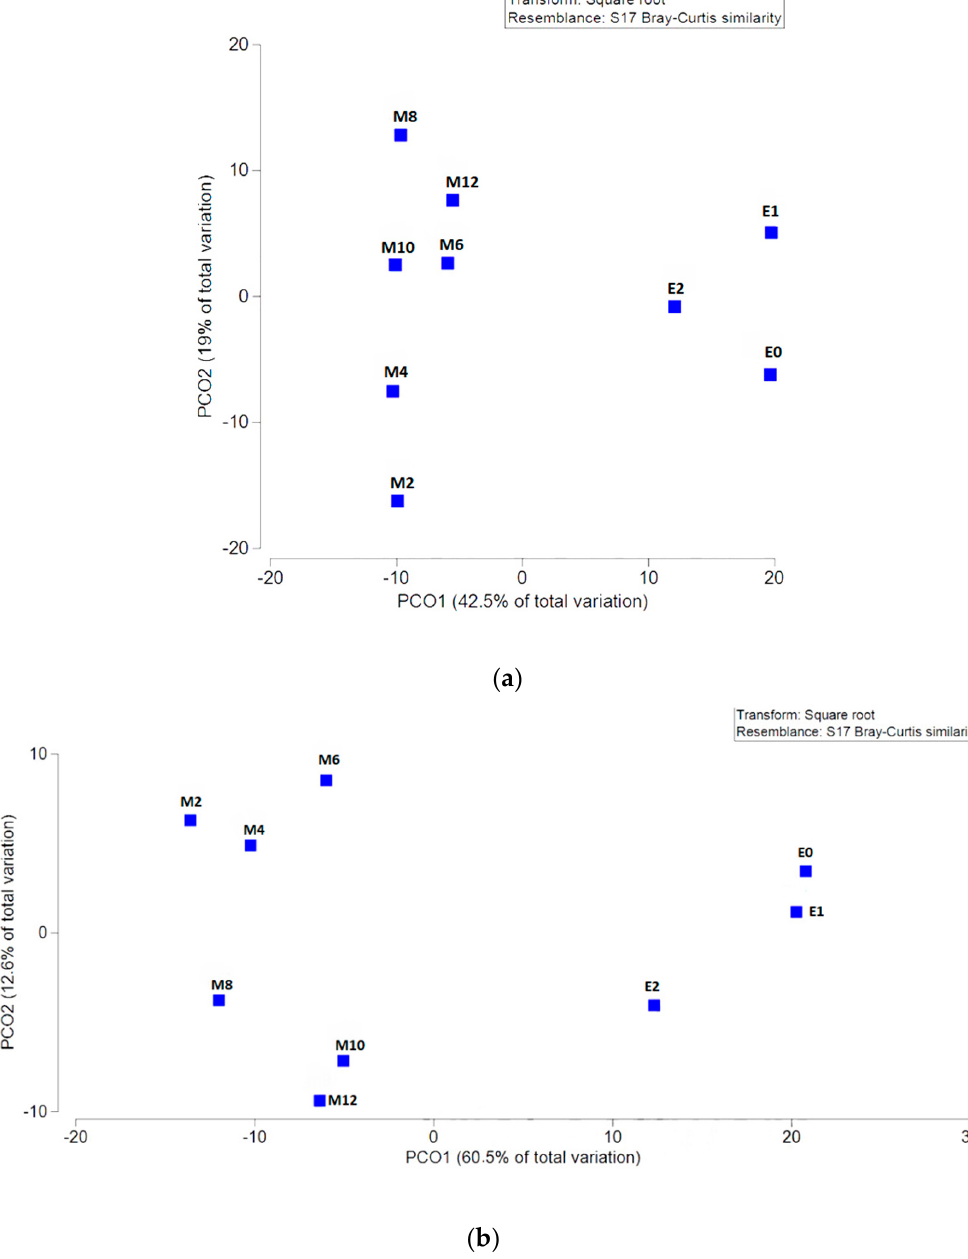
Figure 2. Principal coordinate ordination analysis (PCO) based on the OTU for ( a ) MspI -digestion, and ( b ) HhaI -digestion showing different time points of EEN and post-EEN treatment. PCO was analysed using Bray-–Curtis distances with centroids (3b).